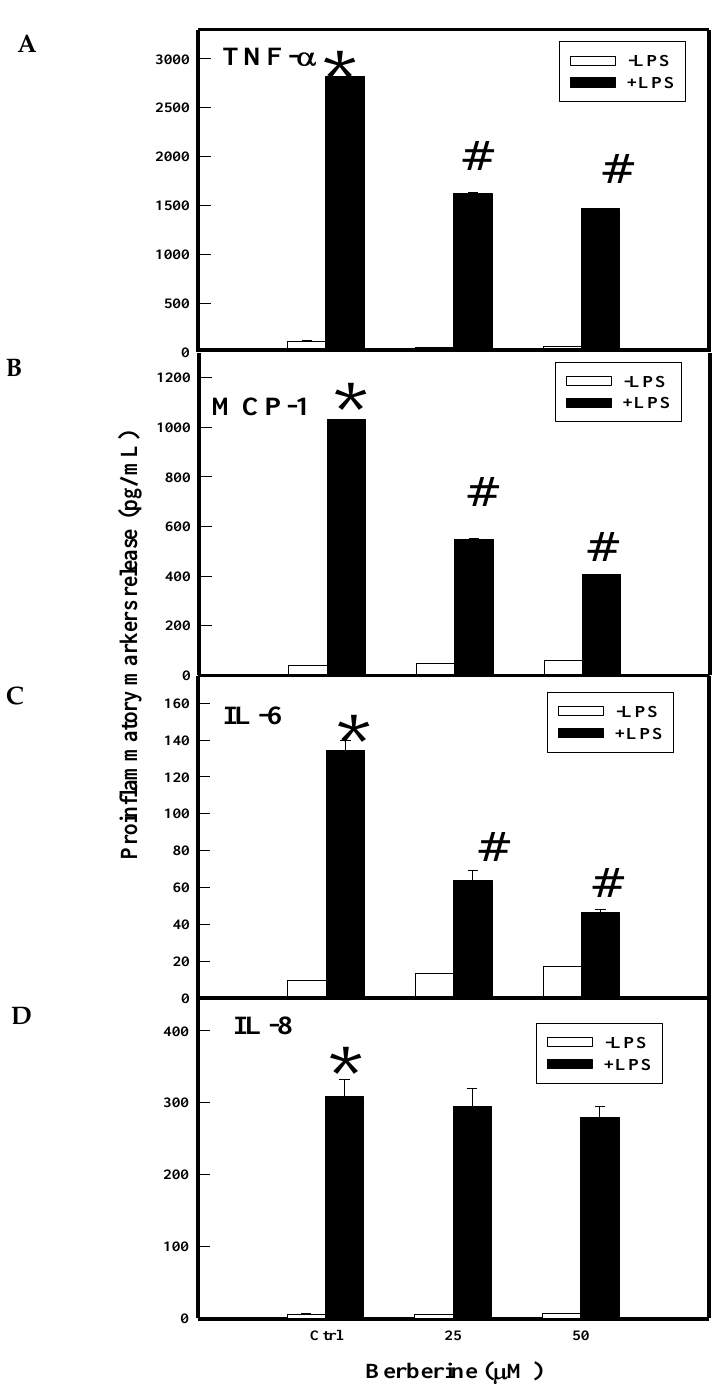
Figure 3. Effect of BBR on LPS-induced proinflammatory markers by ELISA. THP-1 cells were pretreated with BBR and induced with LPS. At the end of the treatment, cells were spun and the culture supernatant collected. Protein levels of the markers TNF-α ( A ), MCP-1 ( B ), IL-6 ( C ), and IL-8 ( D ) were quantified by ELISA. Ctrl (control) represents cells incubated without berberine. Data represent mean ± SD of three independent experiments and # indicates p < 0.001 compared between treated and untreated with controls, * indicates p < 0.001 between the control groups.